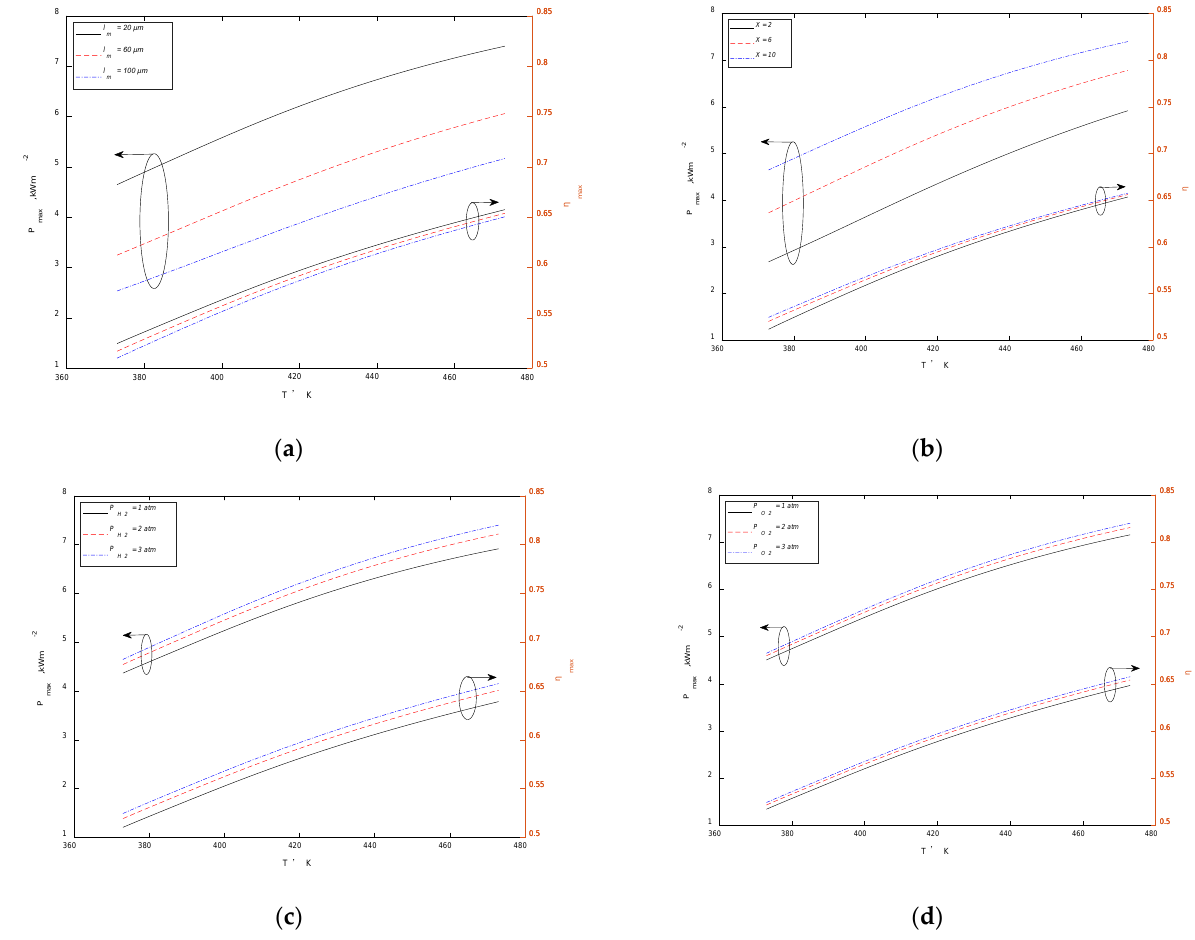
and of HT-PEMFC under different parameters. ( a ) Different . ; ( d ) different p O 𝑃𝑃 𝑚𝑚𝑚𝑚𝑚𝑚 𝜂𝜂 𝑚𝑚𝑚𝑚𝑚𝑚 2 2